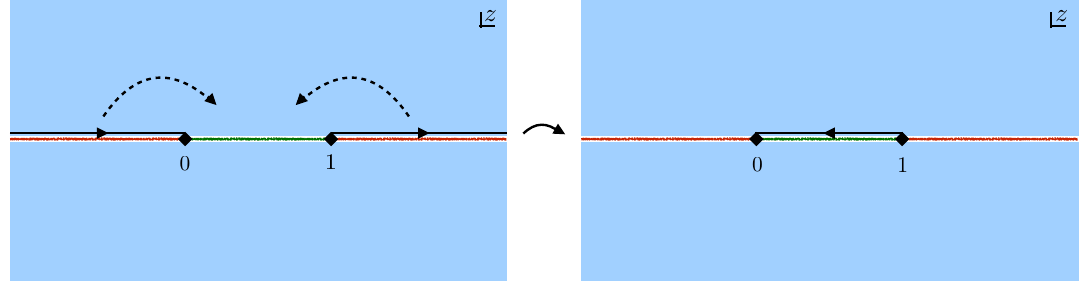
Figure 1 . The contour deformation bringing the \top-of-the-branch-cut" contributions of the Lorentzian inversion formula to the Euclidean region. The left (cid:12)gure depicts the second and third term on the r.h.s. of equation (3.14). The two semi-in(cid:12)nite contours can be combined with a semi-circular contour at in(cid:12)nity and collapsed on top of the interval z 2 (0 ; 1), giving the r.h.s. of equation (3.16), as depicted in the (cid:12)gure on the right. The branch cuts of e G ( z ) are shown in red (cid:0) 1 (cid:1) and the branch cut of H (cid:1) in z